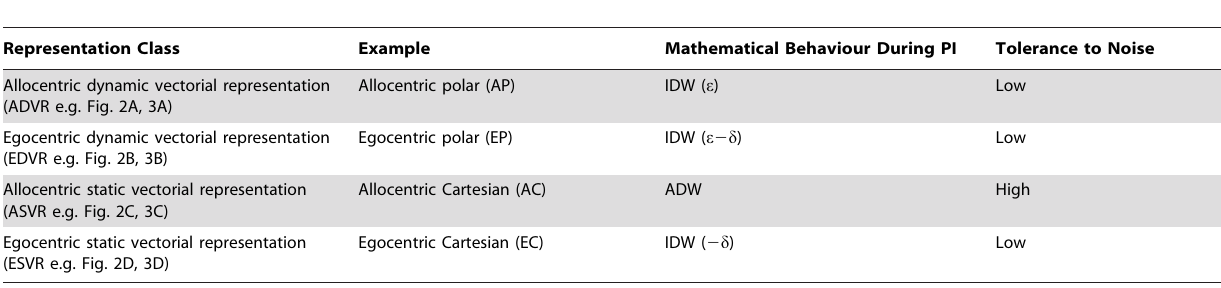
Table 1. Extended classification of representations of Euclidean